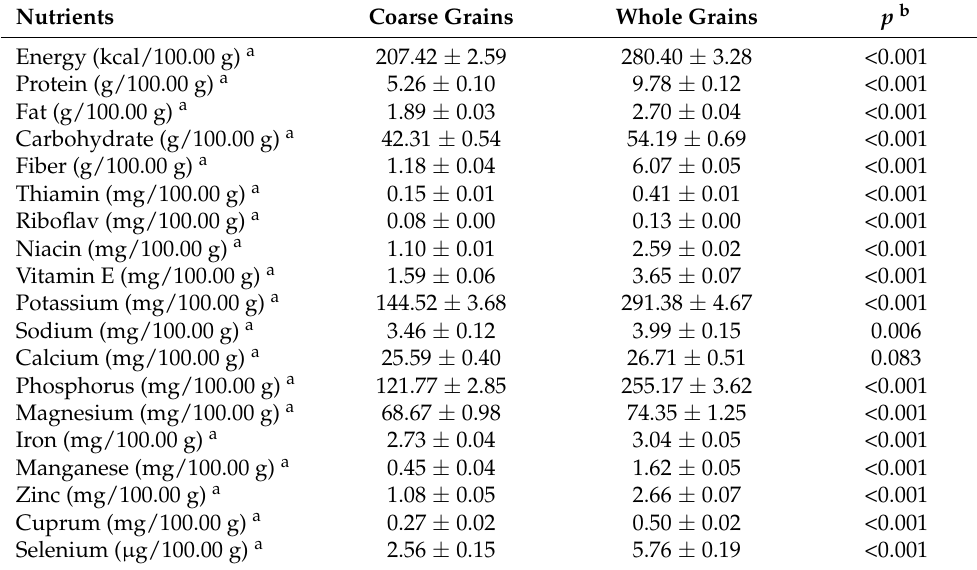
Table 5. Nutrients of coarse grains and whole grains a .